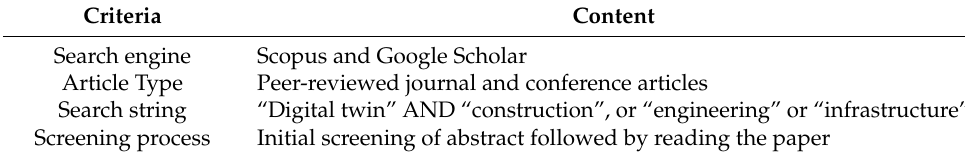
Figure 2. Distribution of Articles over the years. 4. Analysis Based on the review and content analysis conducted on the 53 papers on digital twins in construction, a taxonomy of their applications was derived, and nine areas were iden- tified as shown in Figure 3. This addresses RQ2 (How can we classify digital twin appli- cations?). These areas include energy, life cycle analysis, disaster management, education, structural health monitoring, facility management, DTs for cities, infrastructure manage- ment, and miscellaneous applications. The search resulted in 53 articles, which are dis- cussed in the upcoming sections.